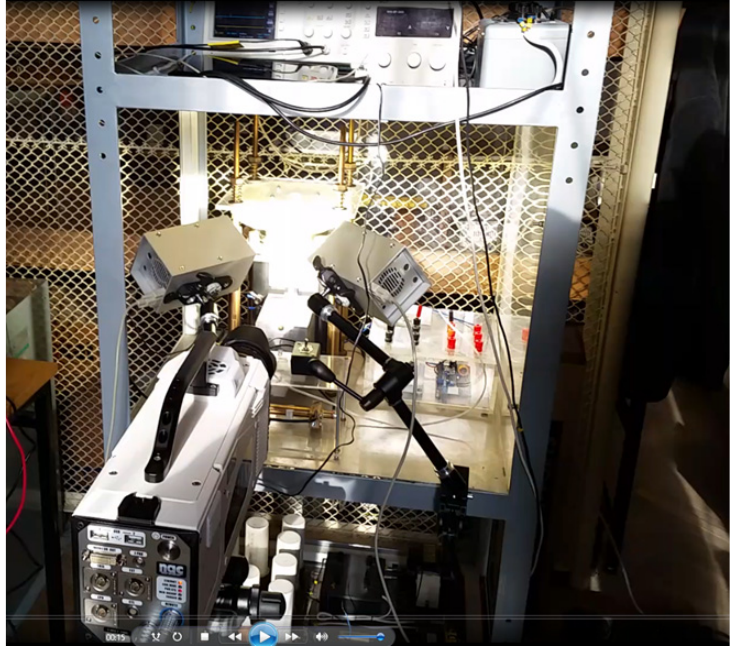
Figure 4. Photo of the station for measuring the movement of the disc using the ultra-fast video camera.